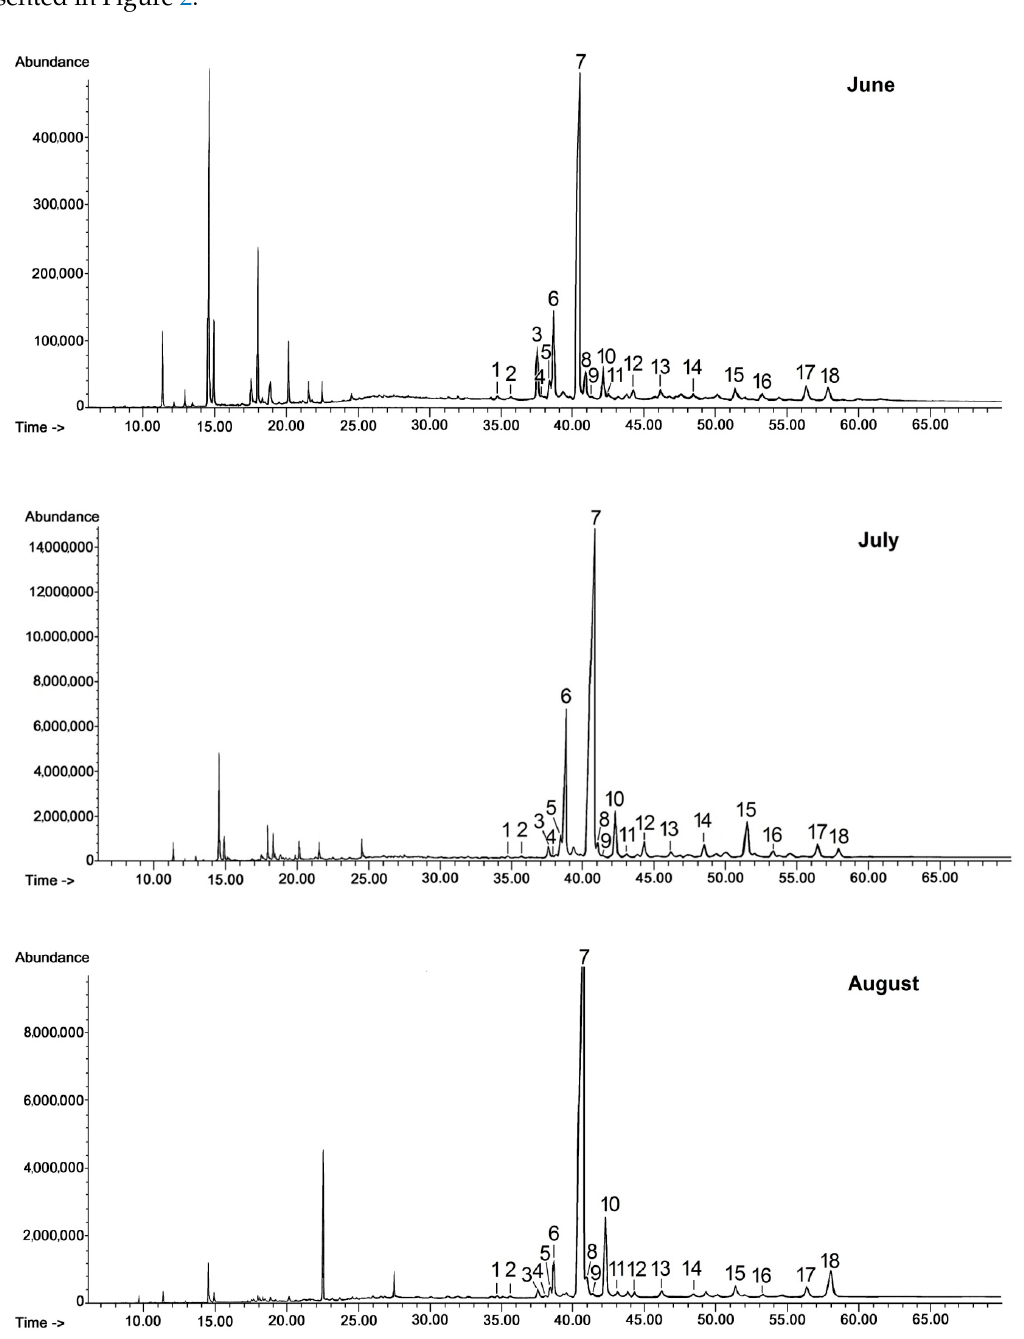
Figure 1. GC-FID chromatograms of the fraction of steroids and neutral triterpenoids obtained from chloroform extracts of cuticular waxes of lingonberry fruit harvested in three developmental stages (young berries in June, unripen full-size berries in July, and ripen berries in late August).